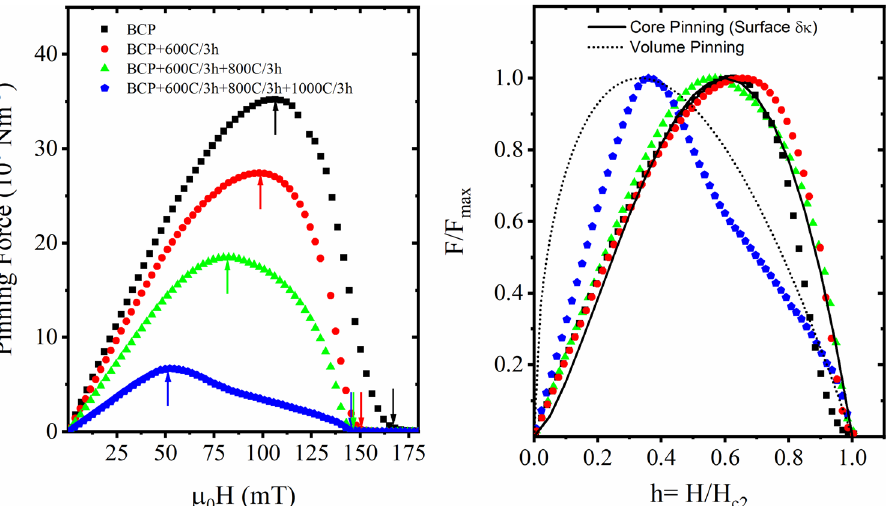
Figure 5. Pinning force curves at T = 7.0 K, comparing the bulk pinning force behavior in the as-received state and after heat treatment: ( a ) Pinning force as a function of reduced field H = μ 0 H (mT) indicates that pinning force magnitude drops significantly with heat treatments, ( b ) normalized pinning force plot of F p / F p,max versus h (H/H c2 ) are similar in the as deformed, after 600 °C/3 h, and 800 °C/3 h heat treatments, and follows the core pinning related to local variation in κ as described by Dew-Hughes, whereas after 1000 °C/3 h the variations do not fit a clear model and collective pinning mechanisms are being further